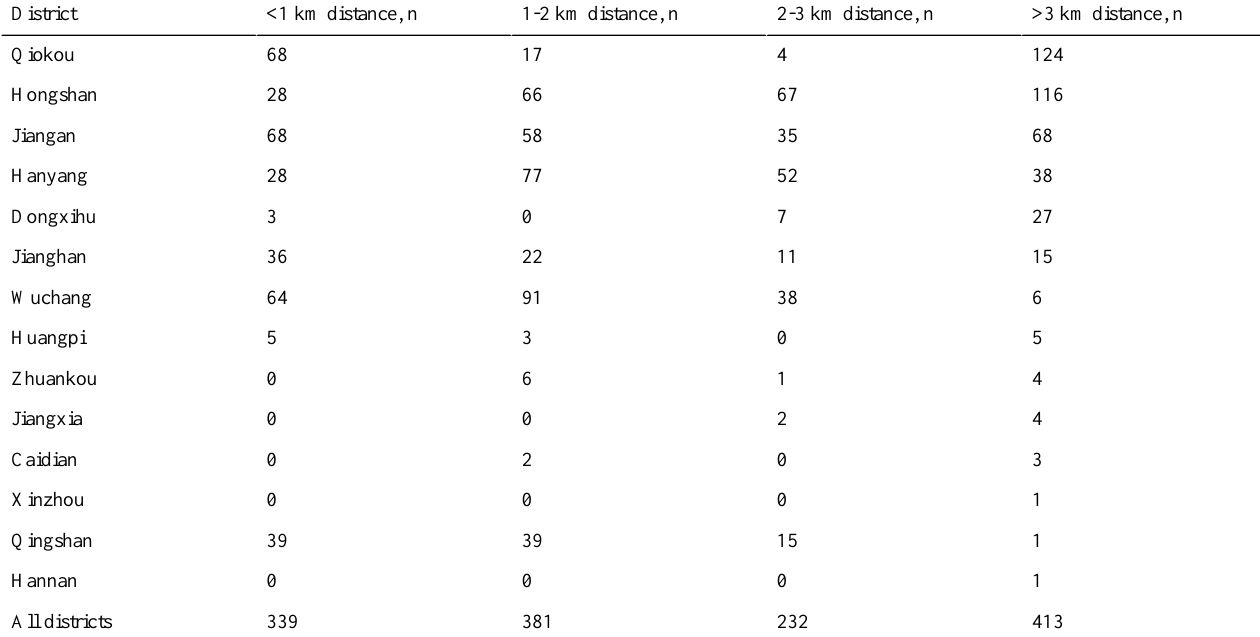
Table 3. Patients’distance to the nearest fever clinic or designated